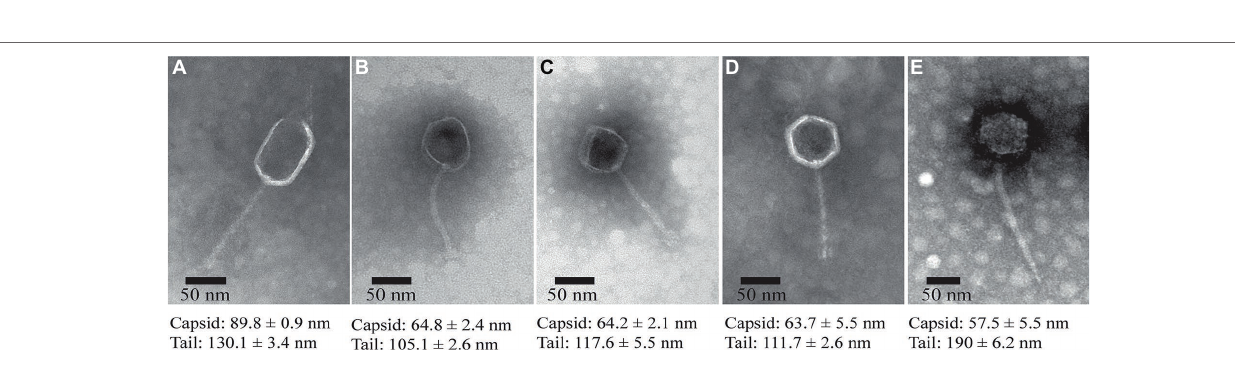
FIGURE 3 | TEM images of the isolated lytic phages. (A) ValLY-3, (B) VspDsh-1, (C) VpaJT-1, (D) ValSw4-1, and (E) VspSw-1. The phages were stained with 2% phosphotungstic acid and visualized at 120,000× magnification with transmission electron microscopy. Scale bars represent 20